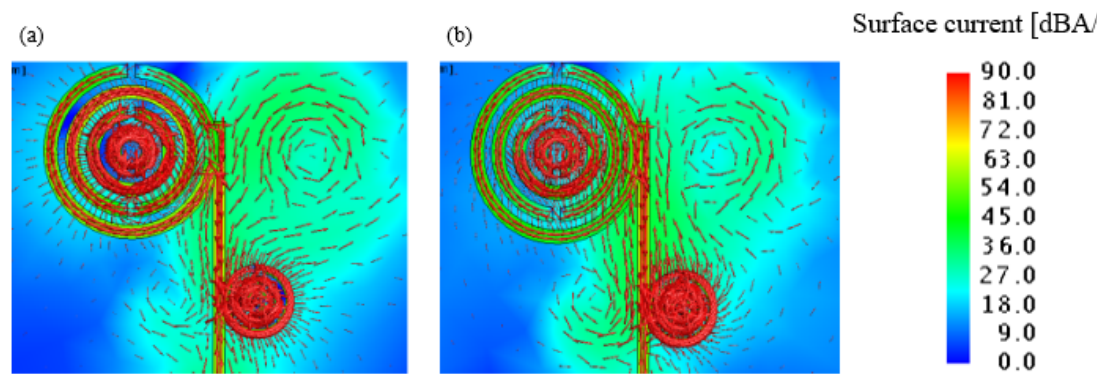
Figure 11. | S 11 | of simulation results.